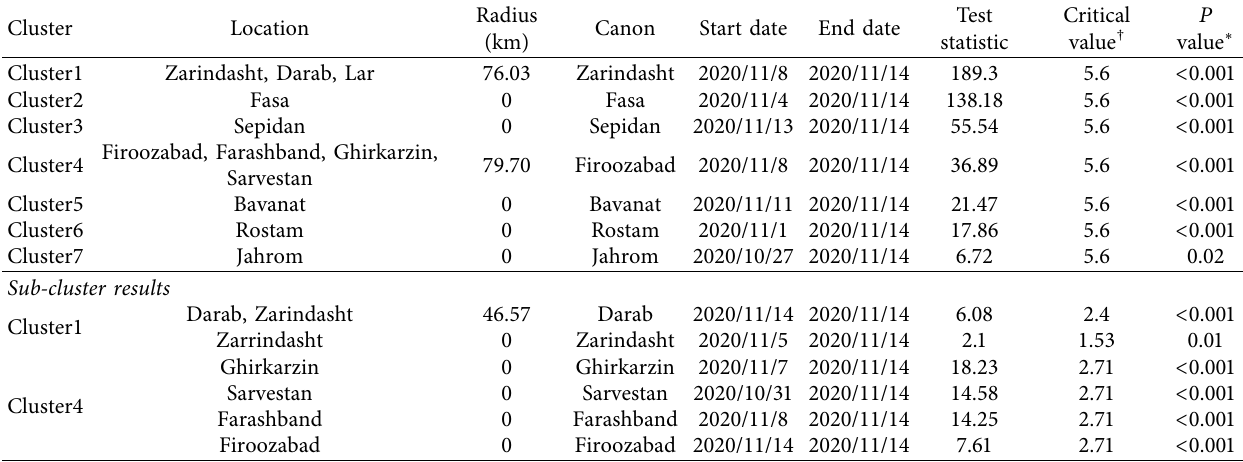
Table 7: The space-time outbreaks of the 59 980 COVID-19 incidence cases accompanied by subcluster analysis in Fars province,